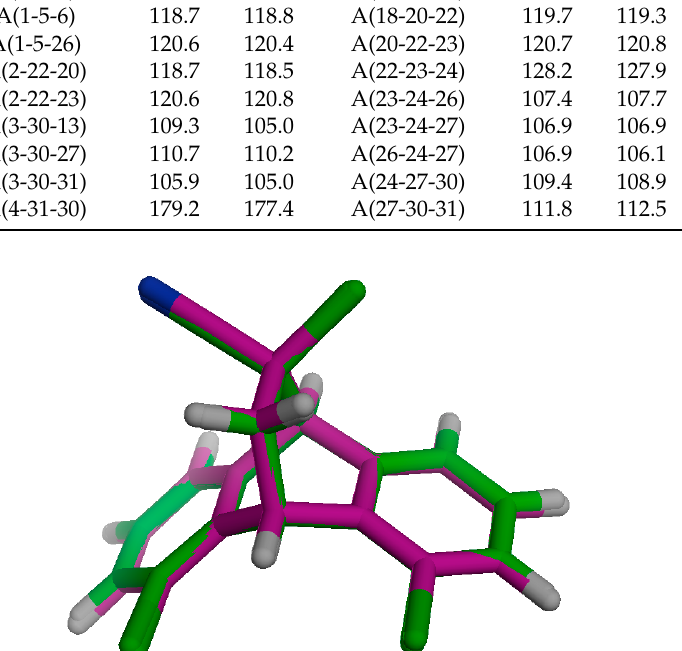
Figure 3. Overlay of the optimized and experimental molecular structure of isomer 1.